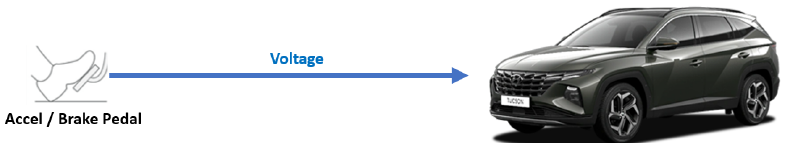
Figure 5. A/D Conversion Acceleration/Brake Pedal Value.